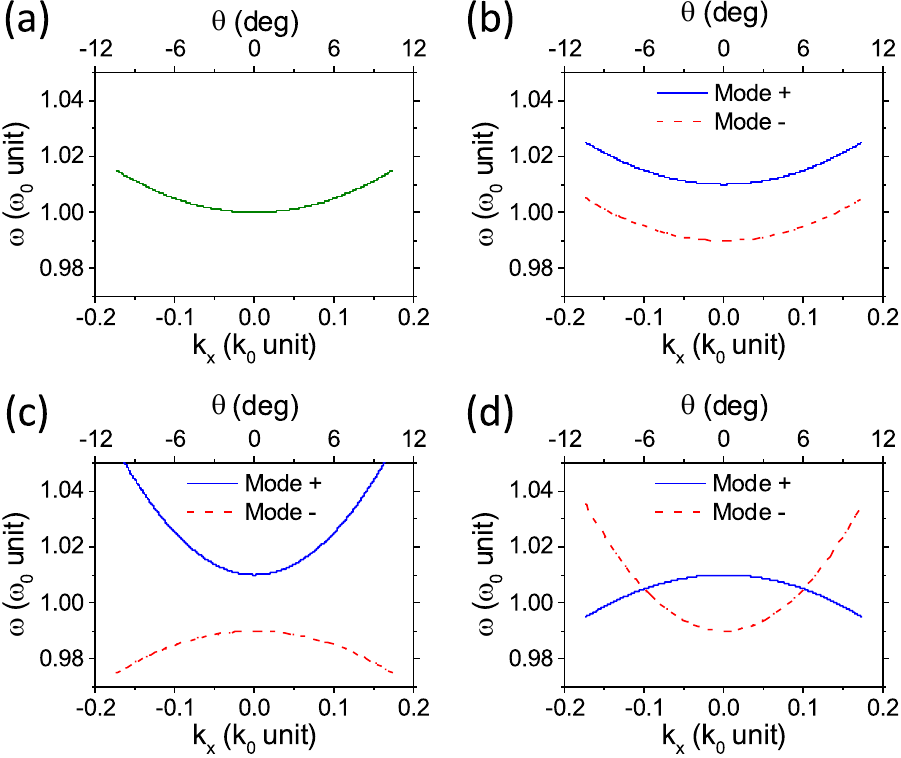
Figure 2. ( a ) The dispersion characteristic of a single VCS with β x = c 2 / ω 0 . ( b – d ) Characteristic dispersions of coupled VCSs when ( b ) α β  , ( c ) α x = + 2 β x , and ( d ) α x = − 2 β x . Here, Δ ω 0 is assumed to be 0.01 ω 0 . In x x graphs, frequency, ω and wavevector, k x are normalized with respect to ω 0 and k 0 (  ω 0 / c ), respectively, and the Modes + and − denote the blue- and red-shifted mode,